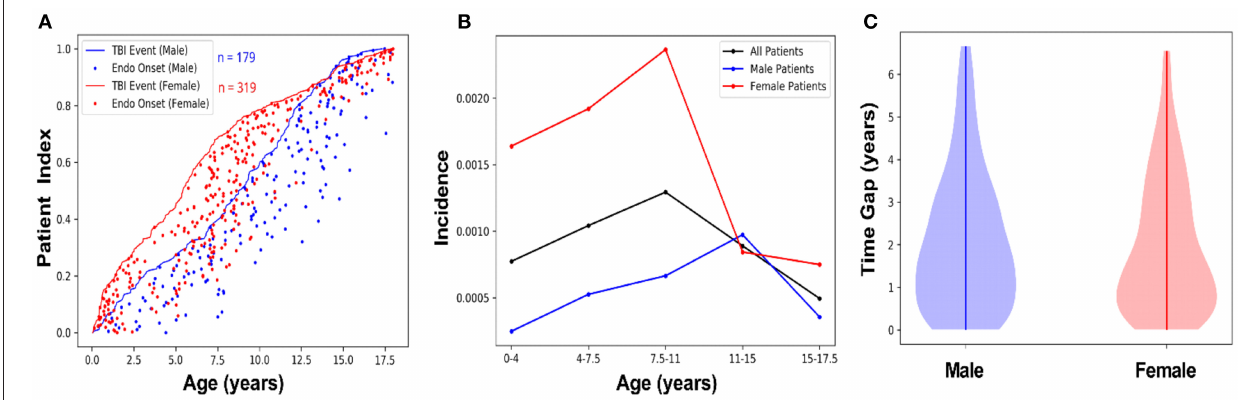
FIGURE 2 | Female subjects show a higher incidence, and an early age of onset, of hypothalamic-pituitary disorder following TBI compared to male subjects. (A) Male and female patients with a TBI diagnosis and subsequent endocrine diagnosis were indexed by age, as a fraction of the total number of subjects in each group. The lines represent male ( n = 179; blue) and female ( n = 319; red) age of each patient when they were diagnosed with a TBI, and the dots tracking along the x-axis from the line indicate male (blue) and female (red) age at the time of their first endocrine diagnosis. (B) Endocrine diagnosis incidence rates after TBI were calculated for male/female patients in blocks of 4-year age groups, with children older than 0 and ≤ 4 years old in the first block, followed by children > 4 years old and ≤ 7.5 years old in the second block, etc. Female subjects diagnosed with a TBI (red line) were more likely to have a central endocrine diagnosis at an earlier age compared with male subjects diagnosed with a TBI (blue line). The overall incidence of endocrine dysfunction peaked between ages 7 and 11. This is driven by the higher overall incidence of post-TBI endocrine diagnoses in female patients, compared to male patients, whose incidence peaks between ages 11 and 15. Incidence rate was calculated as the number of new cases per year of endocrine diagnoses in TBI patients divided by the cumulative population of TBI patients. (C) Data stratified by male/female indicated female patients showed a shorter time gap between diagnosis of TBI and subsequent endocrine diagnosis compared with male subjects, but not necessarily reflect the onset of undiagnosed